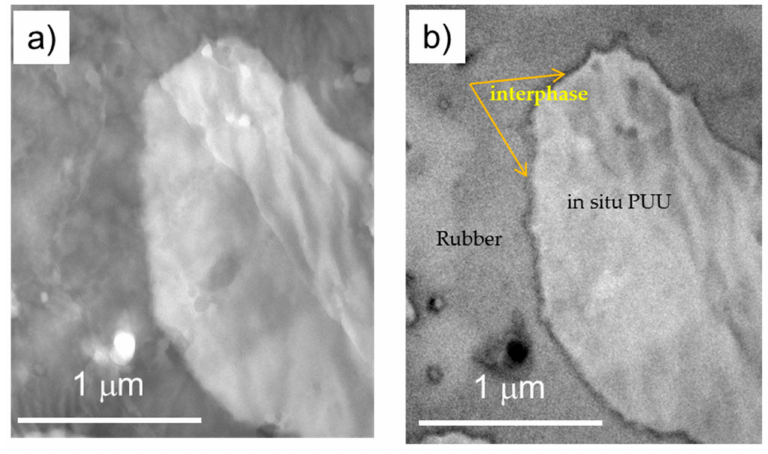
Figure 9. TEM images of nitrile rubber based blend: ( a ) bright field image; and ( b ) carbon